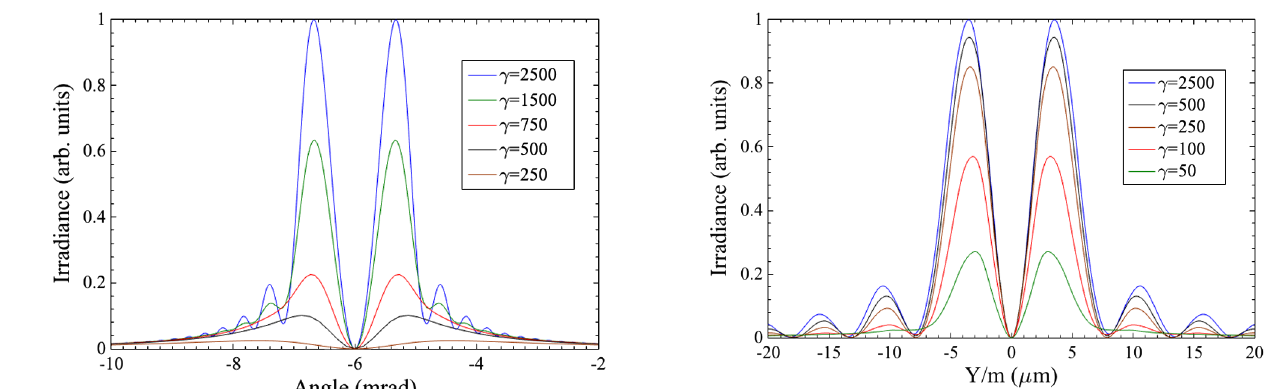
FIG. 3. OTR angular distribution calculated by ZEMAX for λ ¼ 550 nm and for different energies.